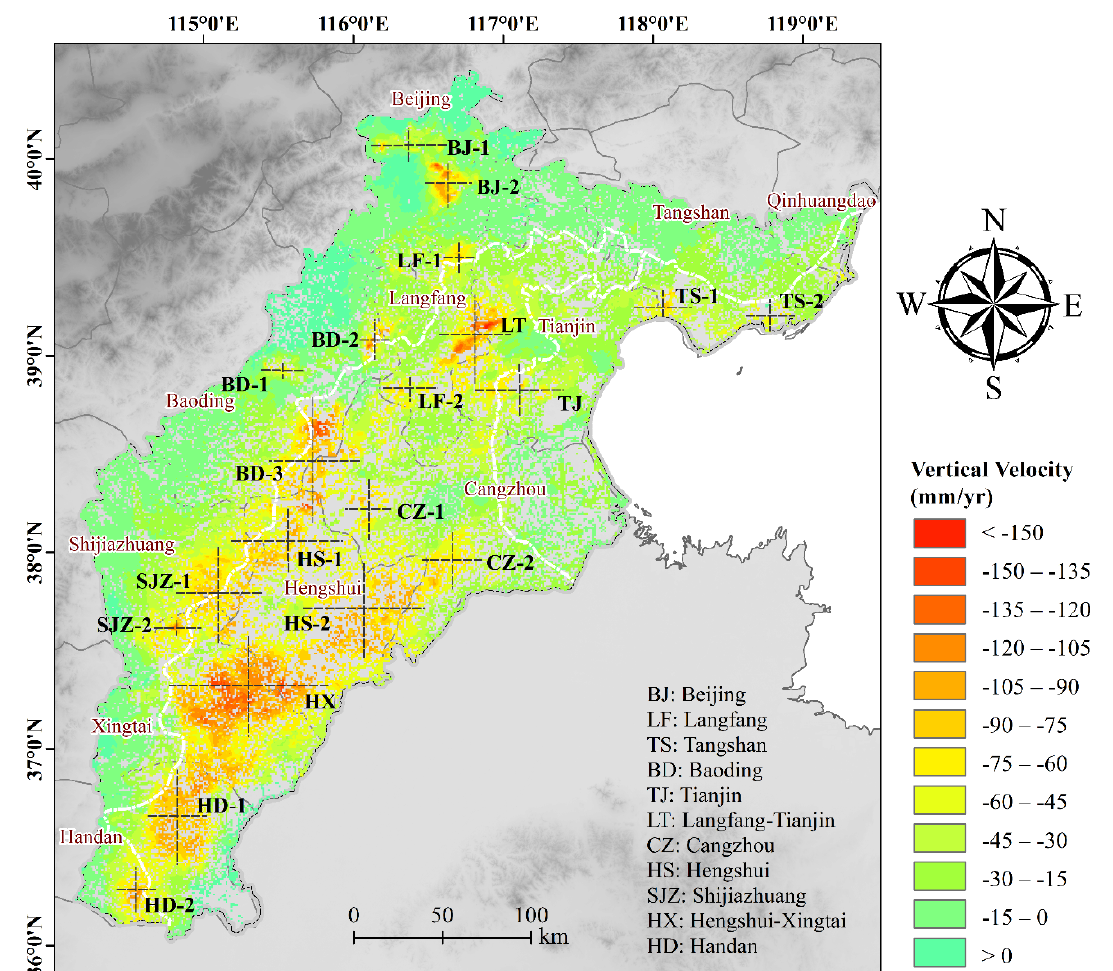
Figure 5. Mean subsidence velocities derived from the S1A data: The deformation profiles passing through the various subsidence depressions are marked by black dashed lines.